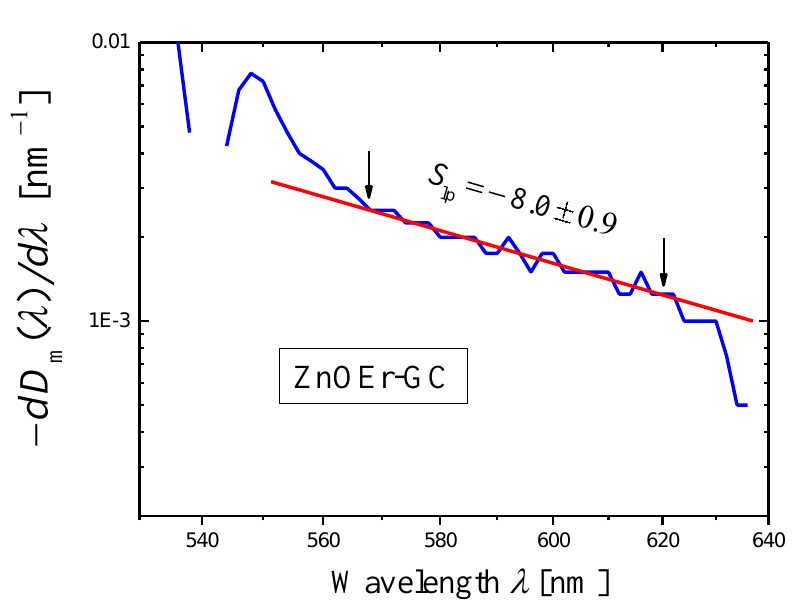
Figure 7. A log–log plot of the dependence of ( − dD i m ( λ ) / d λ ) on λ (blue curve) constructed for the Figure 7. A log – log plot of the dependence of (−𝑑𝐷 𝑖 m (𝜆)/𝑑𝜆) on 𝜆 (blue curve) constructed for the measured optical densities D m ( λ ) of sample of the glass-ceramic ZnOEr-GC. The sample thickness measured optical densities 𝐷 m (𝜆) of sample of the glass-ceramic ZnOEr-GC. The sample thickness h = 1.06 mm. The portion of the curve limited by arrows is approximated by a red straight line using the least squares method, and the slope S lp of the straight line is indicated in the figure. This value of s coincides well with the value obtained by the third method (Equation